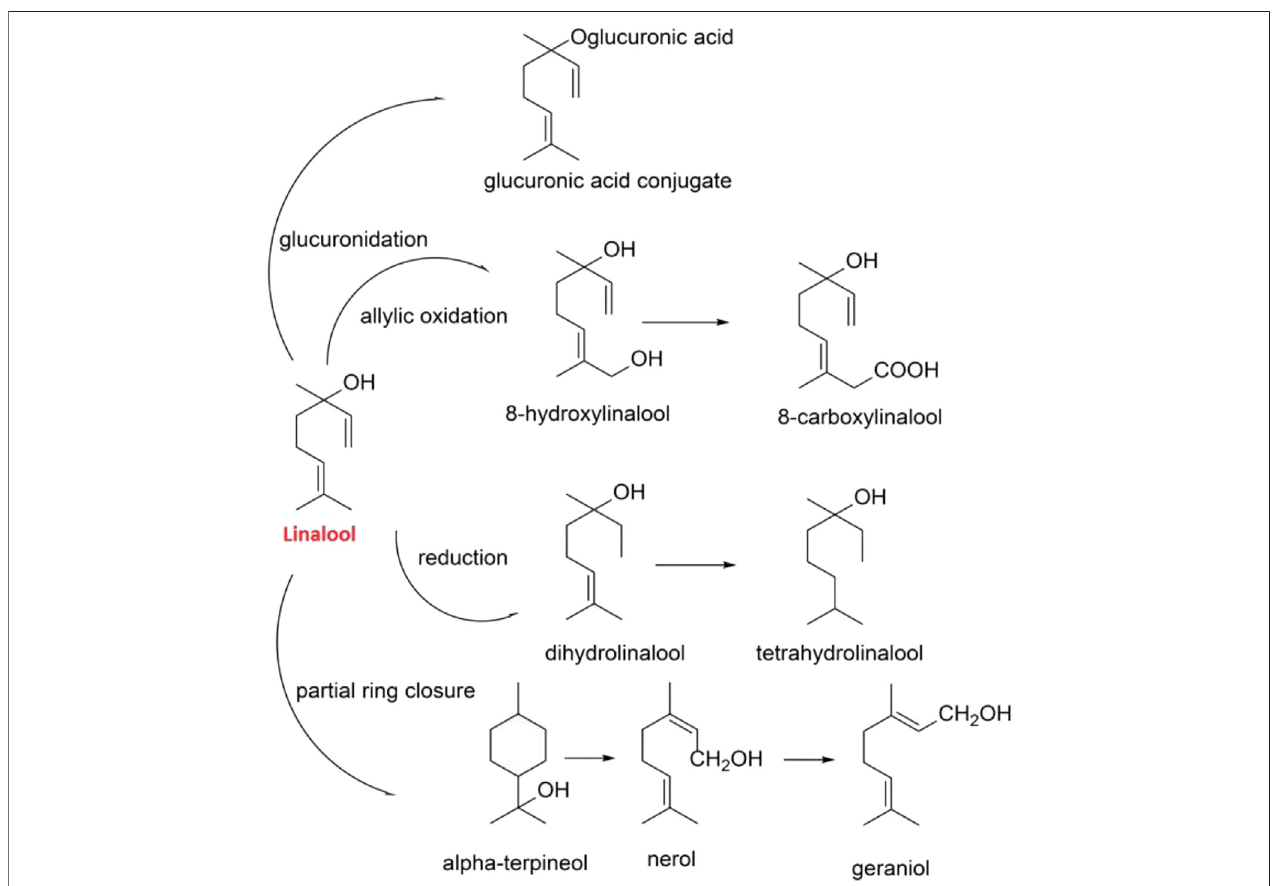
FIGURE 3 | Linalool molecular structure and